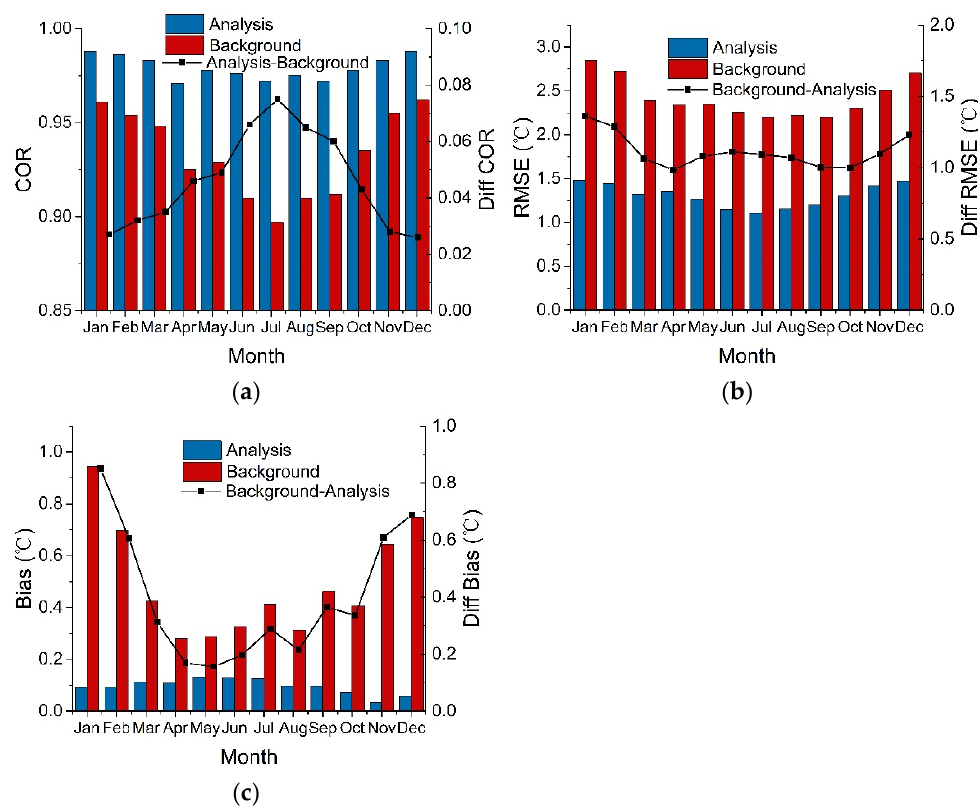
Figure 6. Statistics of monthly evaluation results for background field, analysis field and their difference: ( a ) for COR; ( b ) for RMSE; ( c ) for BIAS.